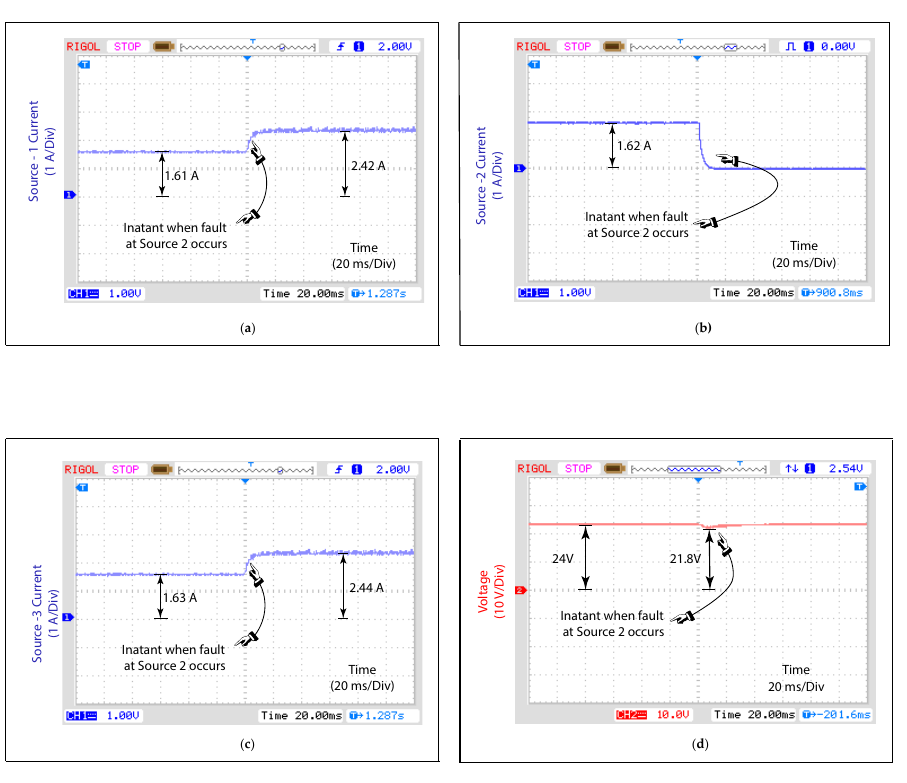
Figure 11. Grid operation of DI-SMC. ( a ) output current of Source-1; ( b ) output current of Source-2; ( c ) output current of Source-3. ( d ) Load voltage during fault